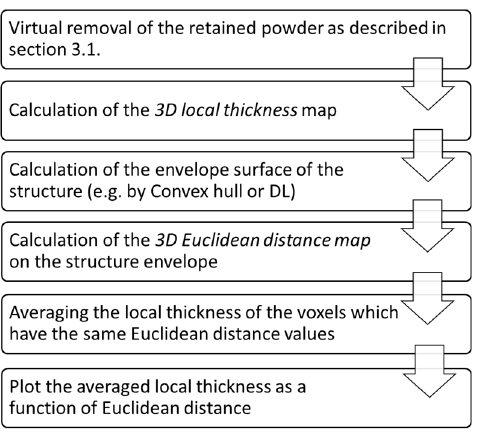
Figure 8. The description of the workflow used for the wall degradation analysis.